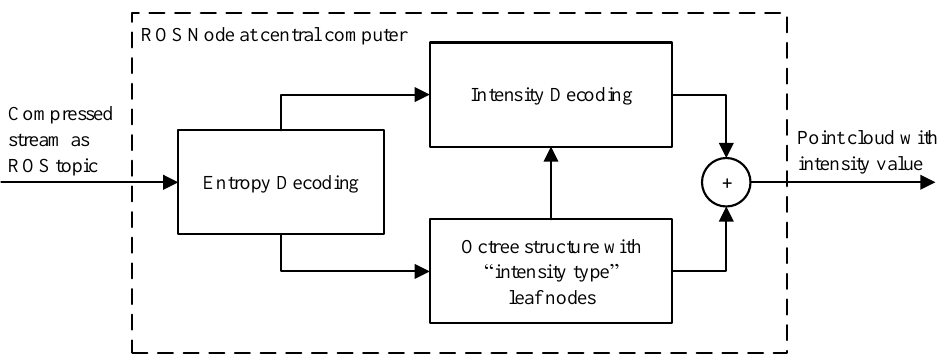
Figure 6. Schematic overview of the decompression principle implemented as an ROS node at the central computer.